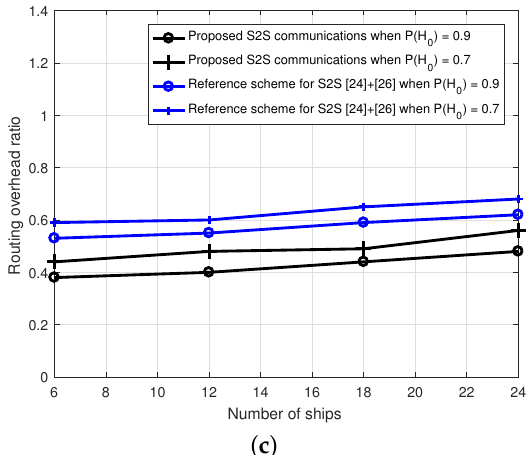
Figure 8. Performance comparison between the proposed S2S and the reference scheme for S2S in terms of ( a ) packet delivery ratio, ( b ) end-to-end delay, and ( c ) routing overhead